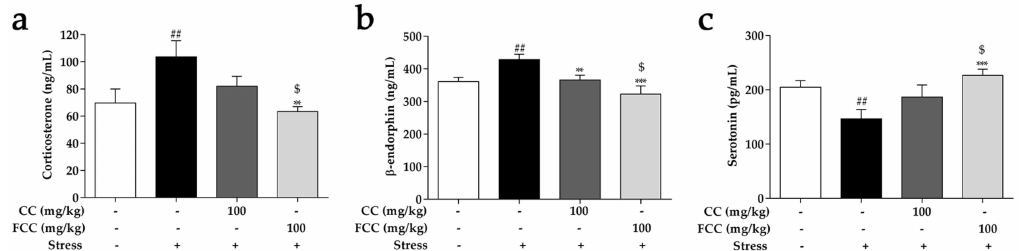
Figure 3. Pretreatment with CC or FCC regulated the stress-related hormones in stress-induced rats. Levels of ( a ) corticosterone, ( b ) β -endorphin, and ( c ) serotonin were evaluated by ELISA kits. “ + , -”: Rats were treated with or without CC extract, FCC extract or stress. The data are expressed as mean ± SD, n = 8. ## p < 0.01 compared to the control group, ** p < 0.01, *** p < 0.001 compared to stress group, and $ p < 0.05 compared to CC 100 group.